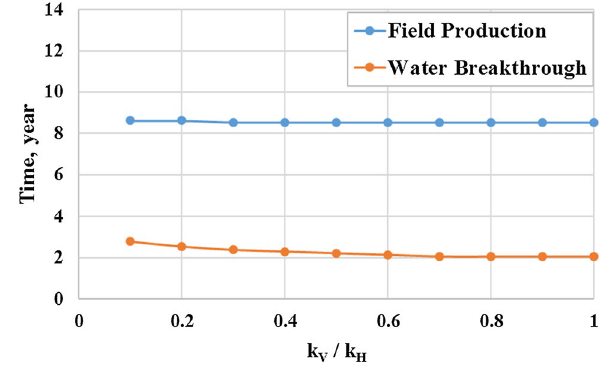
Fig. 33 Gas and oil recoveries for different vertical-to-horizontal per- meability ratios